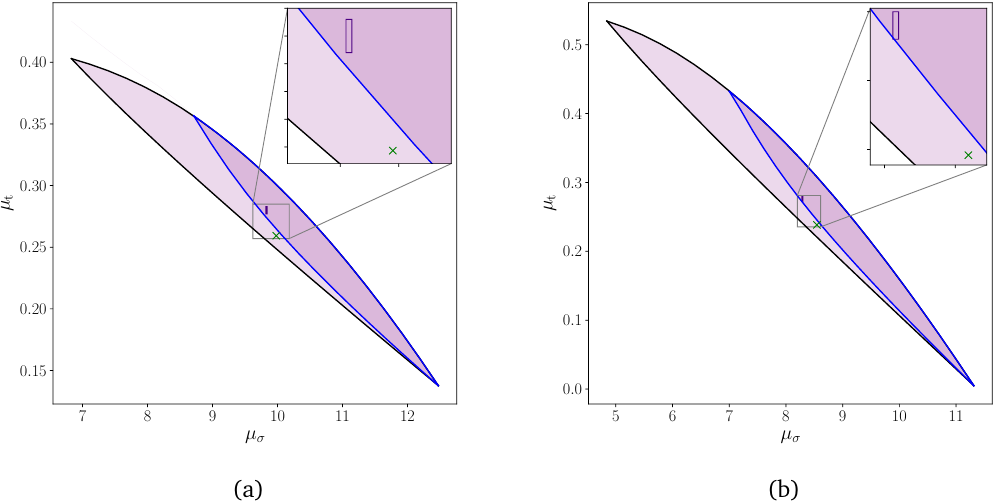
) coefficient space for N = 3 (left) and Figure 10: Allowed regions in the ( µ σ , µ t = 3 and the smaller ones to N = 2 (right). The bigger islands correspond to ∆ min a higher value of ∆ , as discussed in the text. They are mapped by scanning over min µ µ . Monte Carlo (purple rectangles) and truncated σ and finding the bounds on t bootstrap (green crosses) results are included for